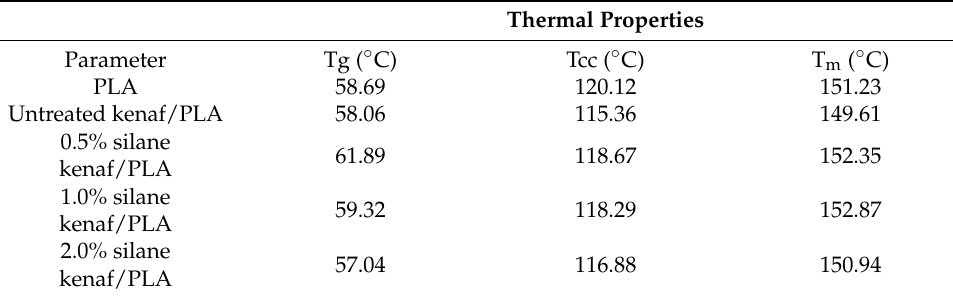
Figure 10. Differential Scanning Calorimetry (DSC). Table 6. Differential Scanning Calorimetry (DSC) data.